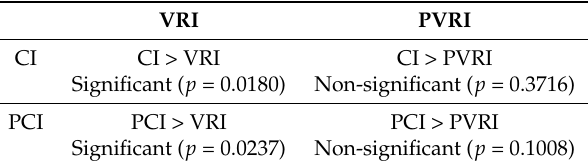
Table 7. T-test with pairs of interfaces in terms of NASA-TLX scores.